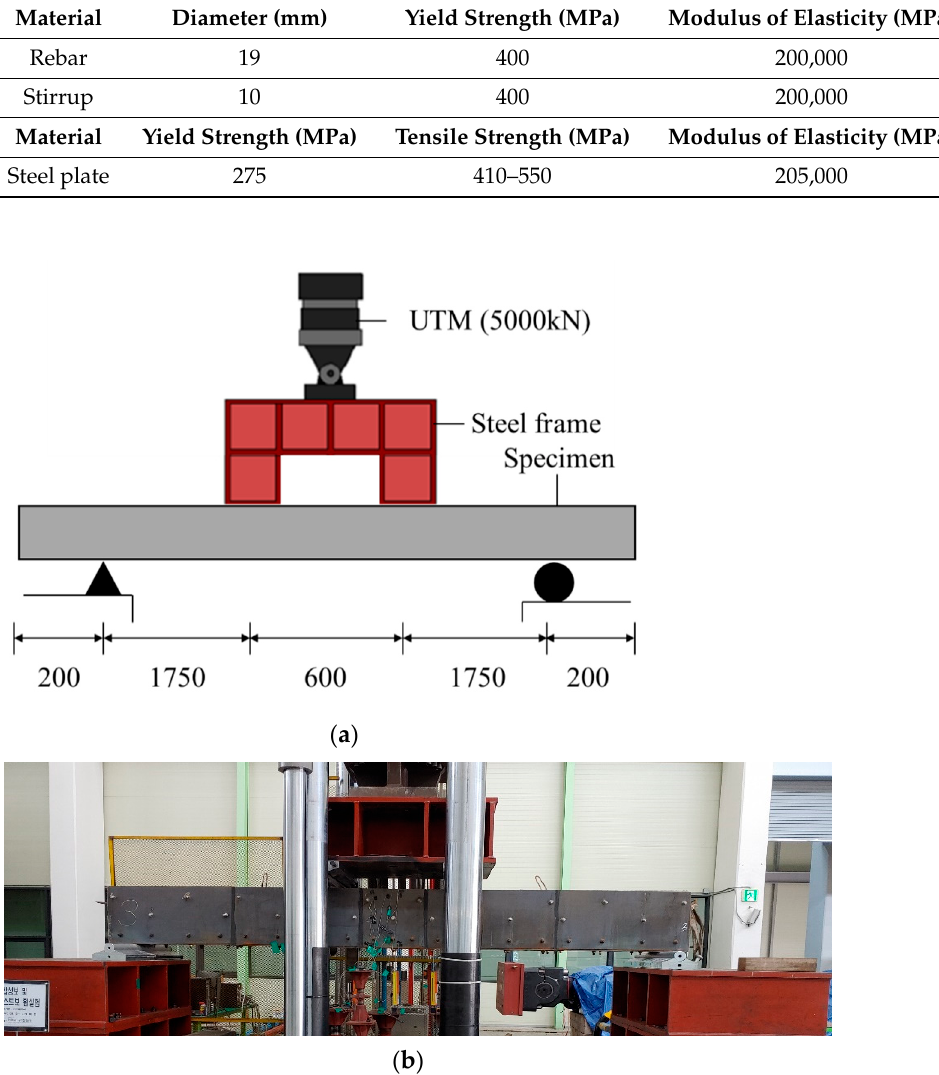
Figure 9. Test setup: ( a ) A schematic of the test setup; ( b ) A photograph of the test setup.